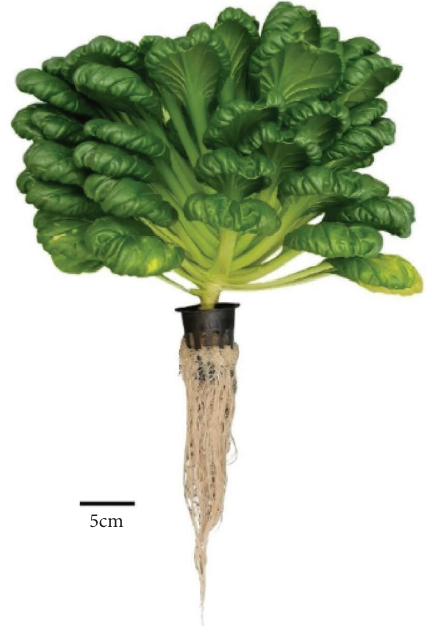
Figure 11: Pagoda mustard is ready to be harvested 40 days after